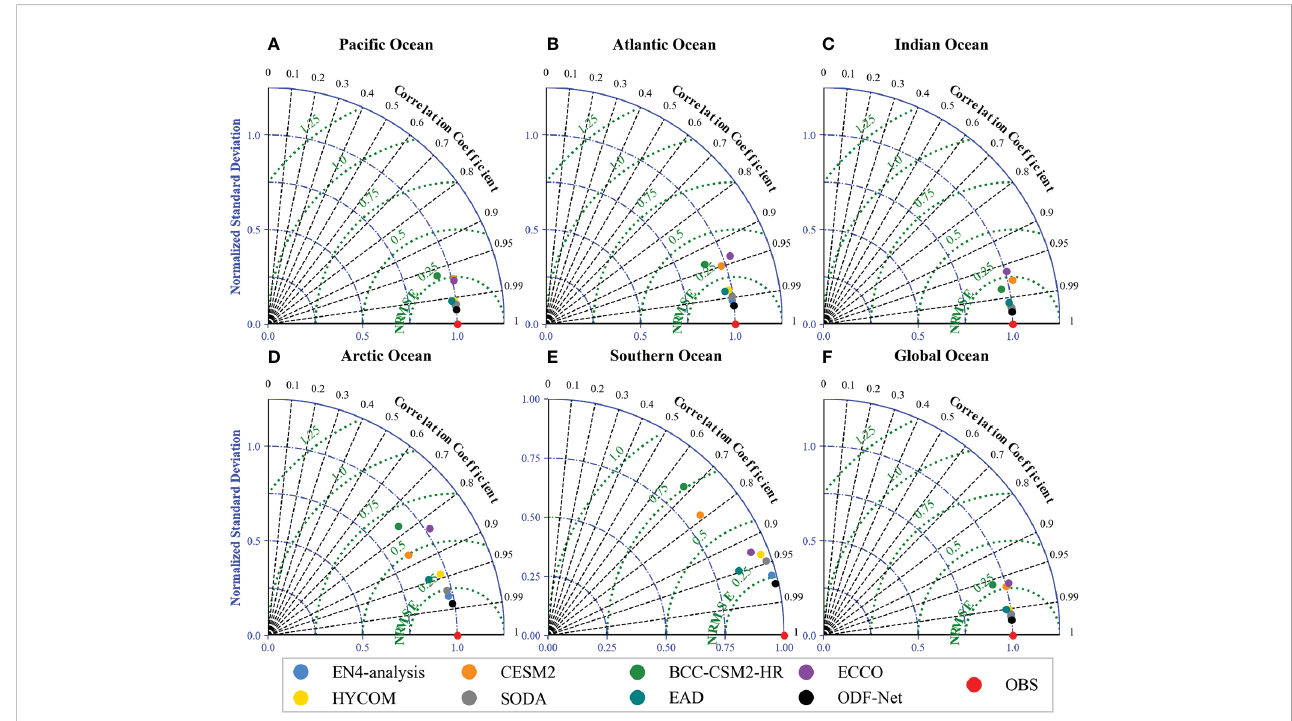
FIGURE 6 Time-averaged Taylor diagram in (A) Paci fi c Ocean, (B) Atlantic Ocean, (C) Indian Ocean, (D) Arctic Ocean, (E) Southern Ocean, and (F) Global